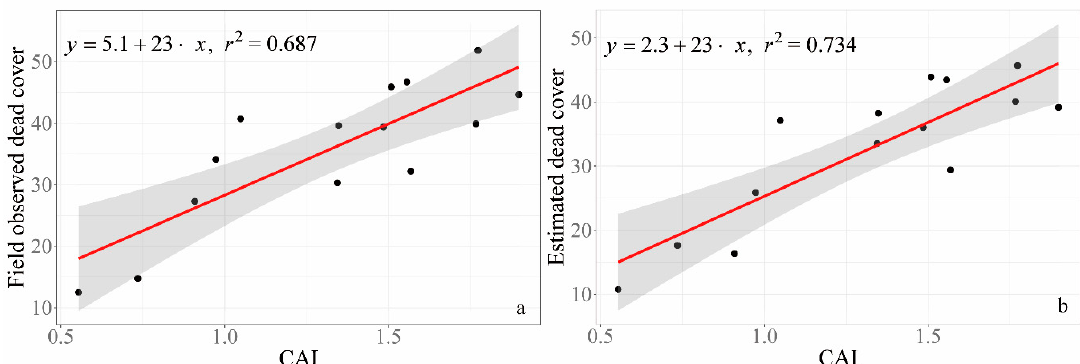
Figure 6. Validation of RGB extracted standing dead cover. ( a ) The relationship between cellulose absorption index (CAI) and visual estimated non-photosynthetic vegetation (NPV) cover (i.e., sum of visual estimated SDM and litter cover). ( b ) The relationship between CAI and the estimated NPV cover (i.e., sum of extracted cover of standing dead matter (SDM) by the method of this study and visually estimated cover of litter in the field).